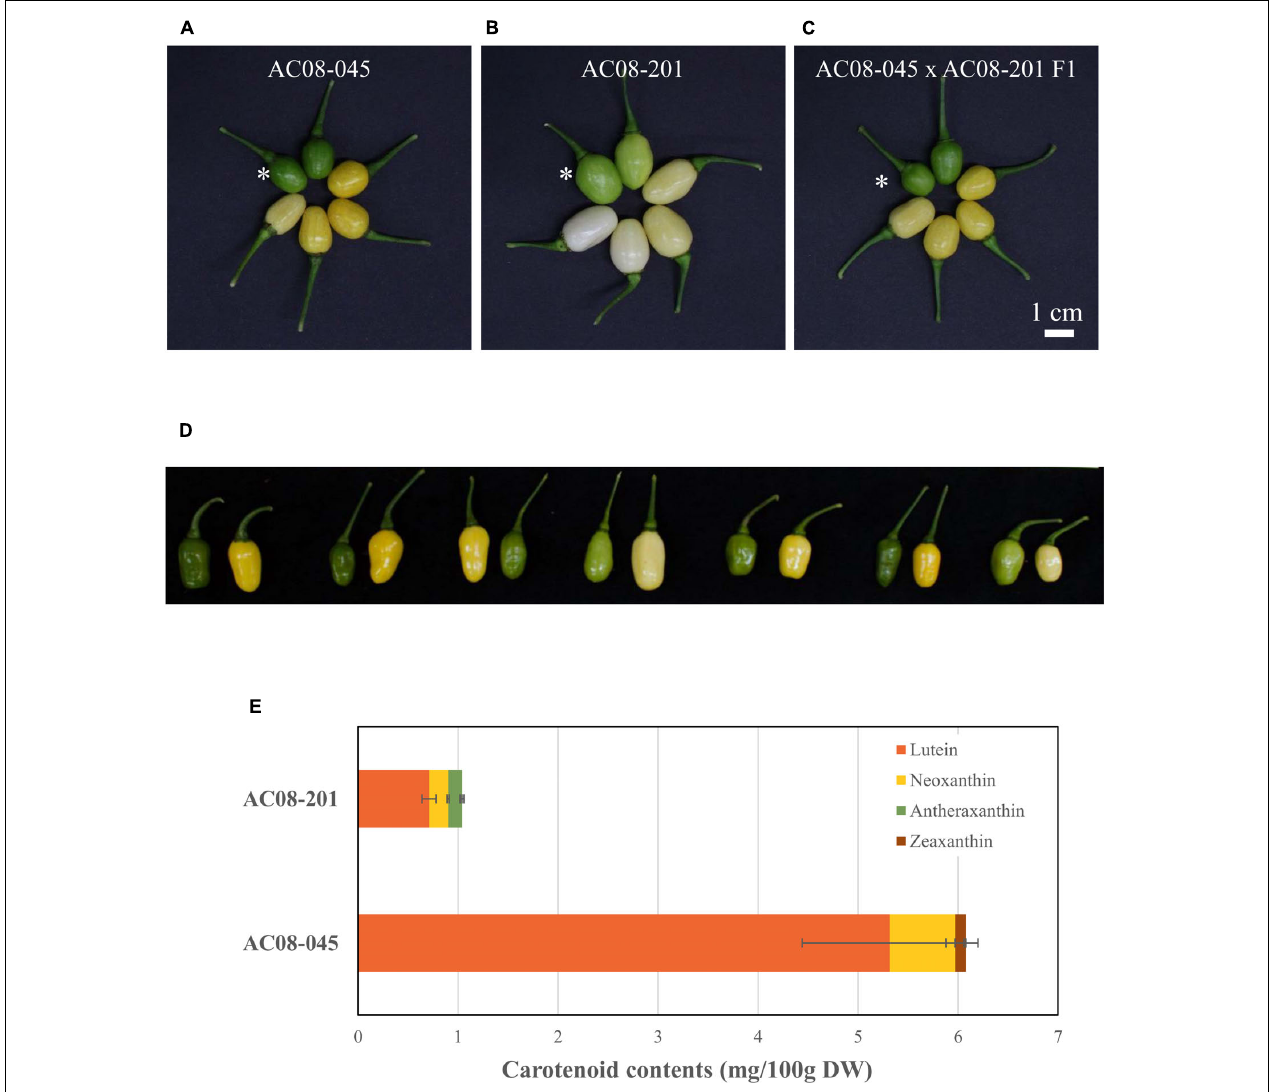
FIGURE 1 | Pepper fruits and carotenoid profiles of AC08-201 and AC08-201 showed less carotenoid accumulation in AC08-201 fruit. (A–C) Pepper fruits are displayed in a clockwise direction according to the ripening stages. An asterisk indicates fully expanded immature fruits. (A) In AC08-045, fruit color changes from dark green to yellow and then light yellow. (B) In AC08-201, fruit color starts out light green and becomes light yellow to white. (C) Fruit color of an F 1 hybrid is similar to that of AC08-045. Scale bar, 1 cm. (D) F 2 individuals from cross between AC08-045 and AC08-201. Seven pairs of immature and mature fruit from each F 2 individuals were selected from F 2 population and shown in the figure. (E) Carotenoid profiles of AC08-201 and AC08-201. Carotenoids extracted from mature fruit pericarp. Levels of four major carotenoids, lutein, neoxanthin, antheraxanthin, and zeaxanthin, are shown in the graph. Horizontal bars indicate standard deviations of each carotenoid